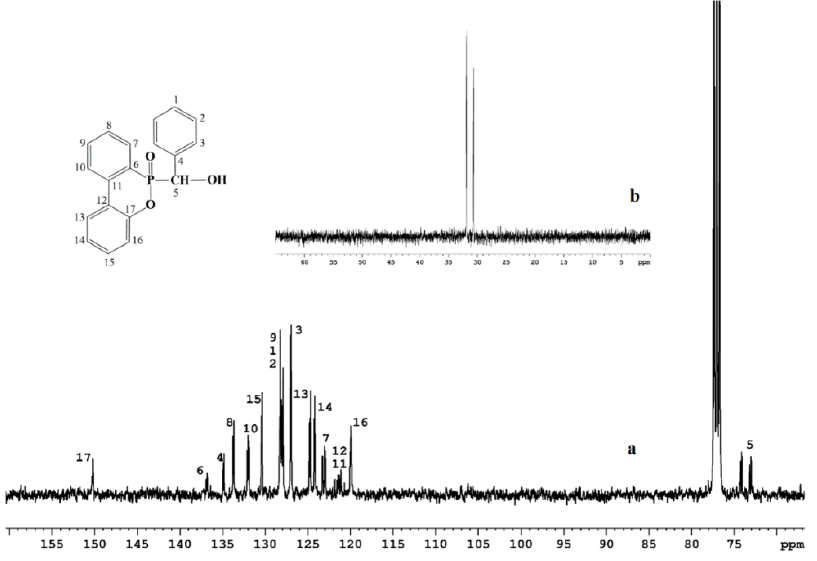
Figure 2. 13 C NMR ( a ) and 31 P NMR ( b ) spectra of PFR.